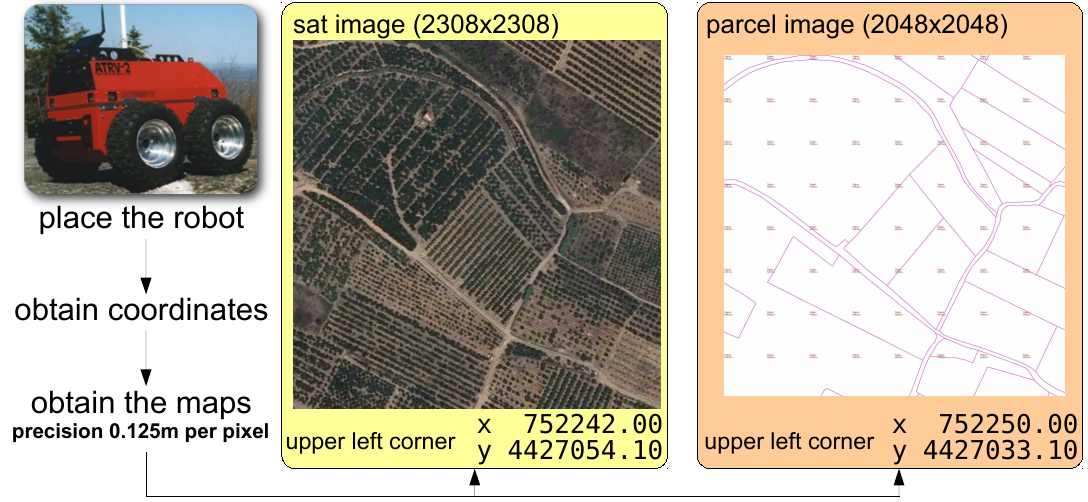
Figure 3. Obtaining the satellite maps from the current position.